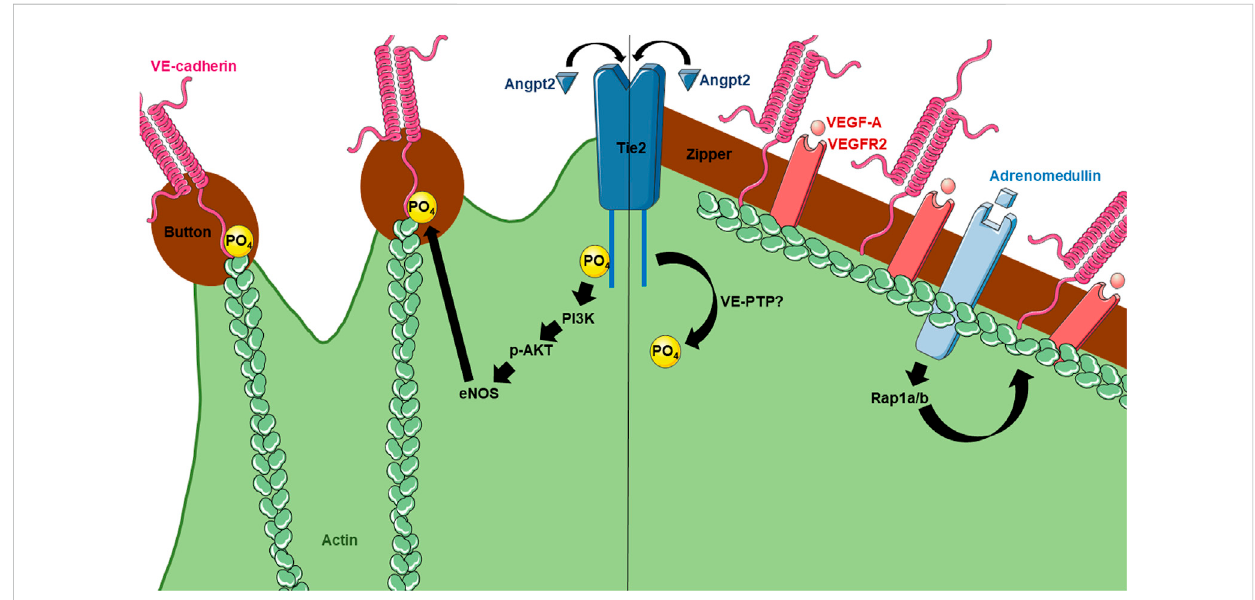
FIGURE 2 Current knowledge of molecular mechanisms regulating lymphatic button and zipper formation. Angpt2 has been found to affect both button and zipper formation. For button formation (left), Angpt2 activates Tie2 receptors on LECs, leading to its phosphorylation and activation of PI3K, AKT, eNOS, and eventually phosphorylation of VE-cadherin. For zipper formation (right), Angpt2 becomes dephosphorylated by unknown mechanisms. However, VEGF-A has been shown to induce zippering in the skin and intestine, but not the lungs. Adrenomedullin also contributes to zipper